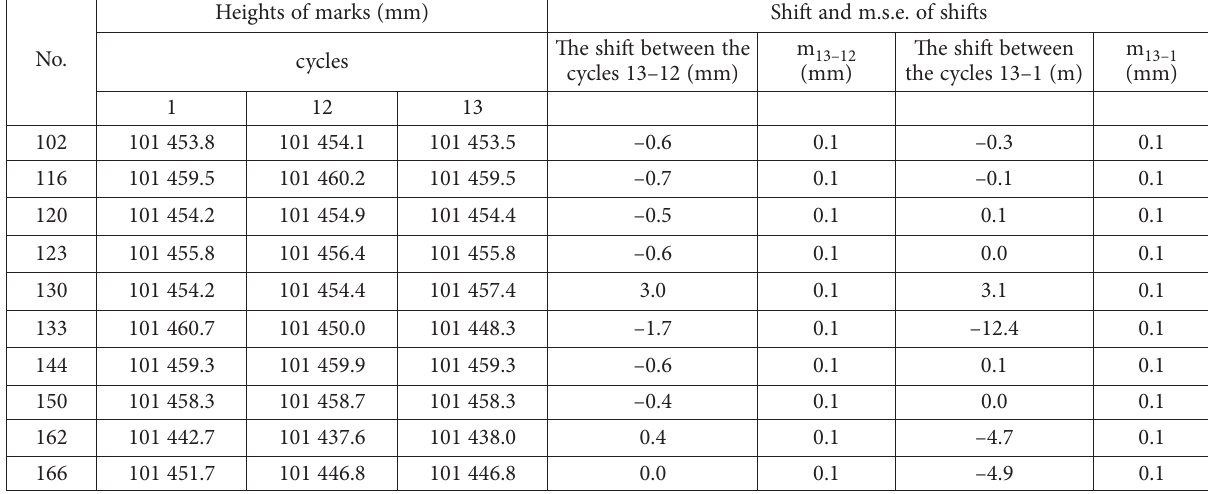
Table 3. Vertical displacements of sedimentary marks of the first floor of “Shuvar” mall according to the 1st, 12th and 13th cycles Heights of marks (mm) Shift and m.s.e. of shifts The shift between the m 13–12 The shift between No. cycles cycles 13–12 (mm) (mm) the cycles 13–1